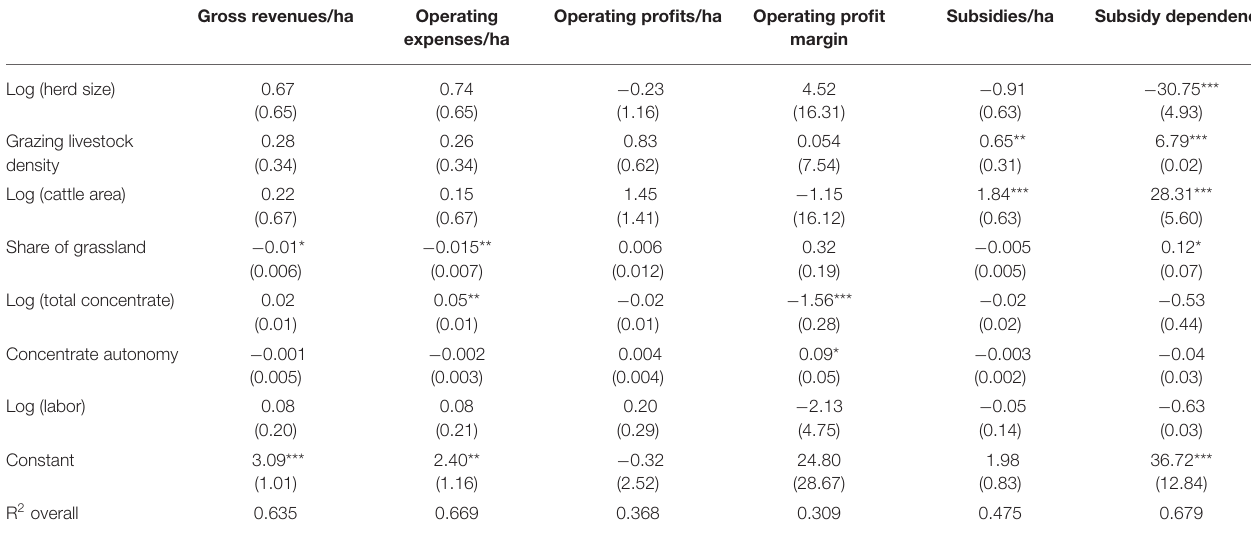
TABLE 4 | Random effects regression analysis for the beef sector—(dependent variables per hectare) ( N = 208). Gross